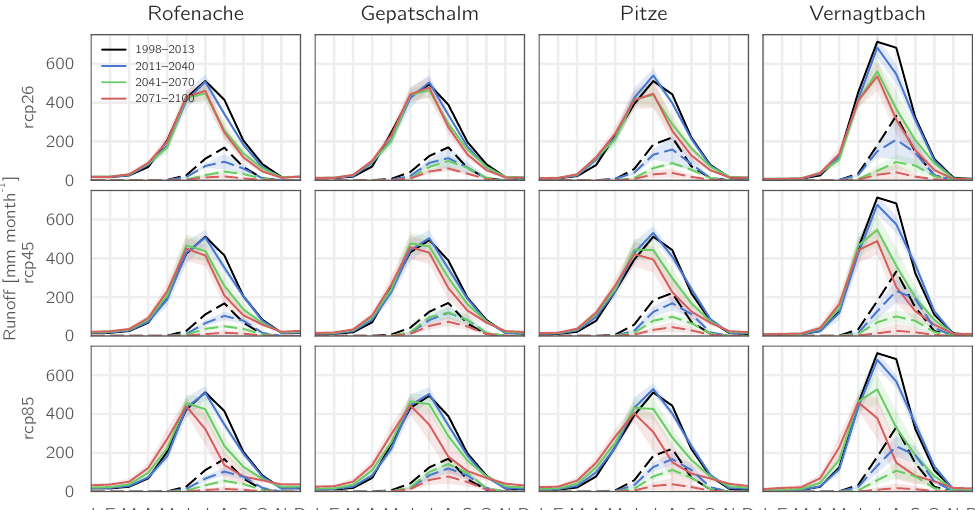
Figure 15. Average monthly runoff (multi-model mean ± 1SD indicated as shaded bands) as simulated for the early, middle, and late 21st century for four catchments and the three emission scenarios. Dashed lines indicate bare ice melt